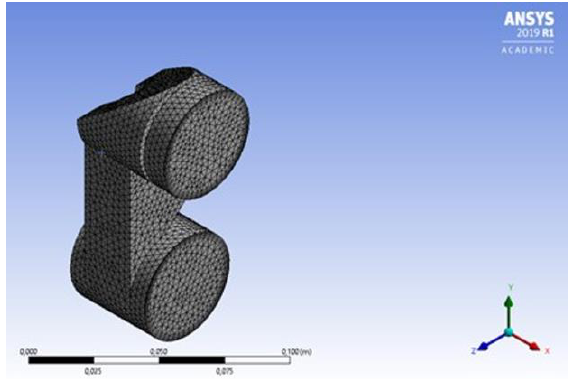
Fig. 9. Mesh of finite elements for the fluid domain of EGR model ana- lyzed